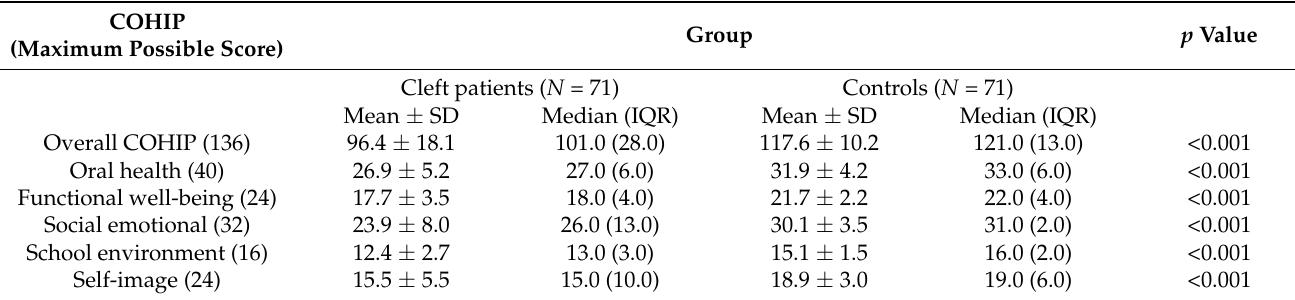
Table 2. Overall and subscale COHIP scores by group.